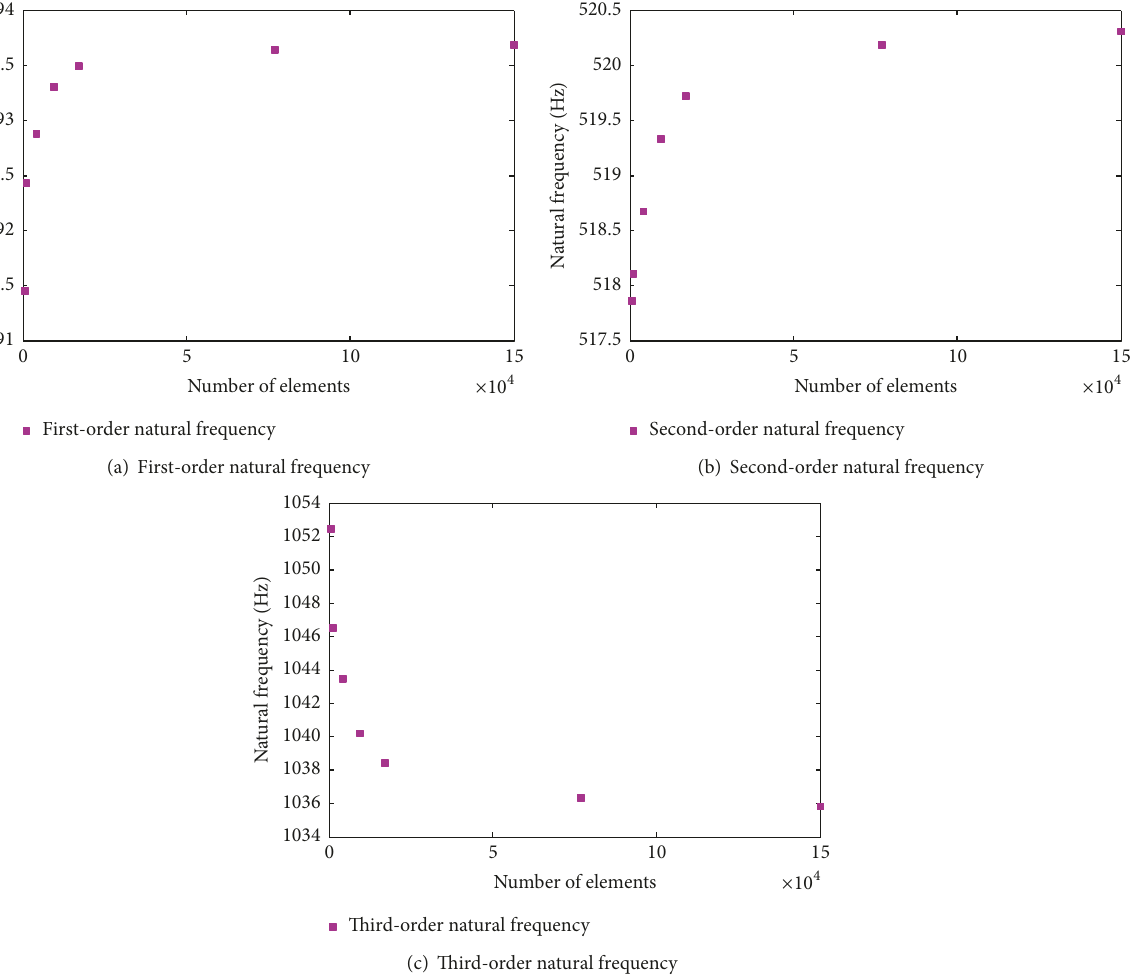
Figure 3: Convergence of first three-order natural frequencies of the cracked